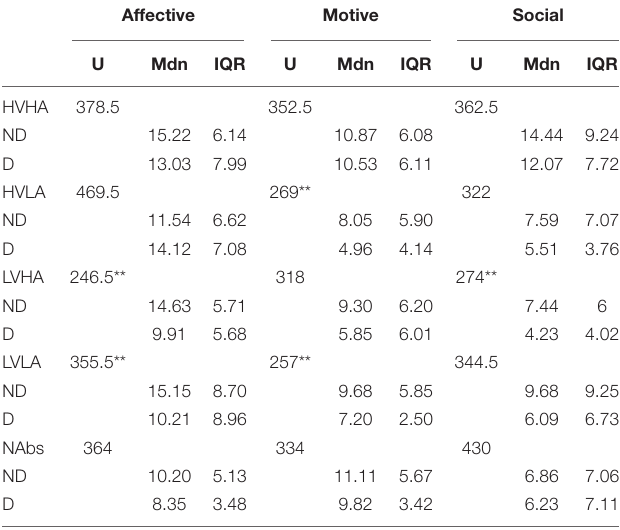
TABLE 6 | LIWC percentages of psychological processes for stimuli categories. Affective Motive